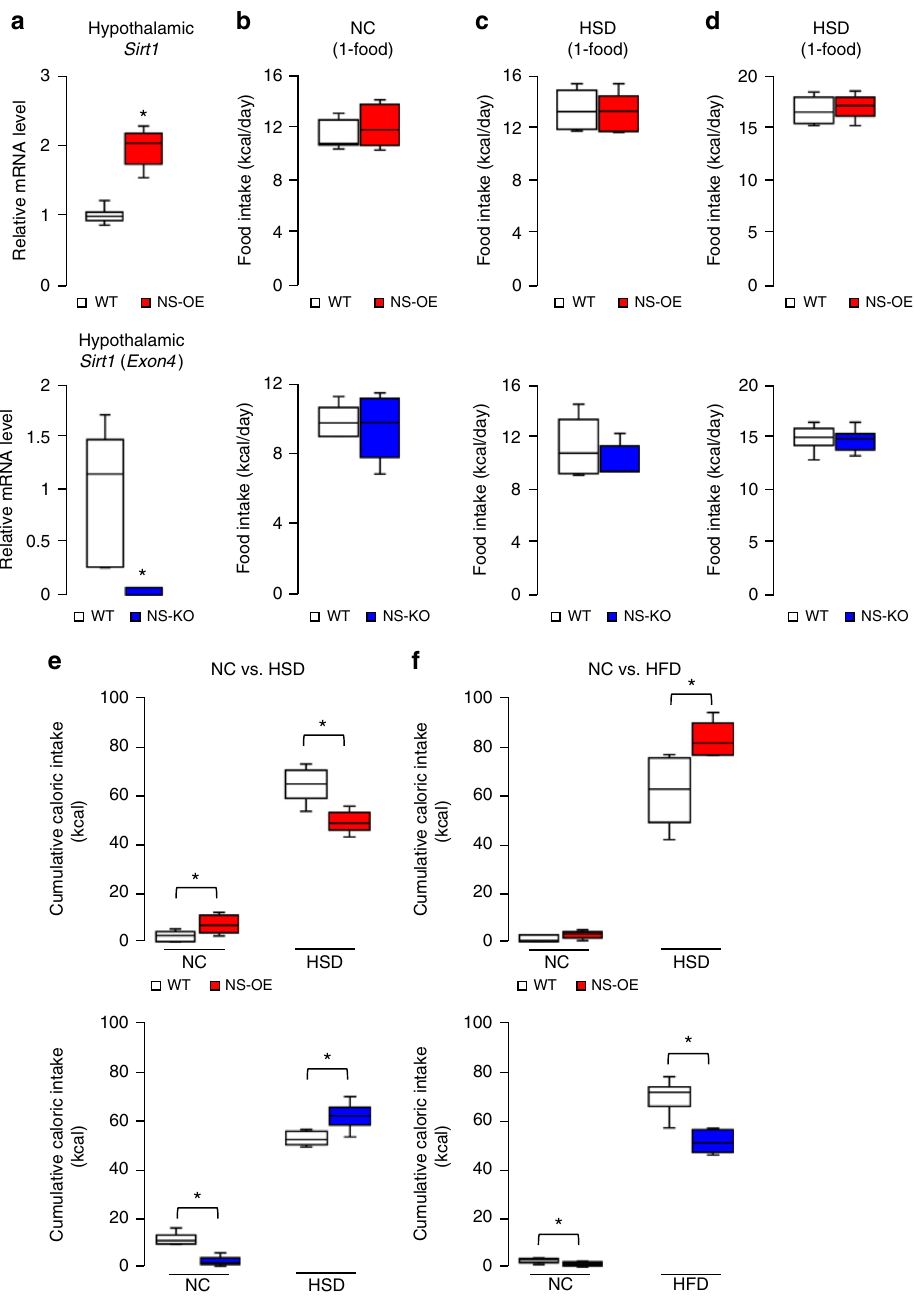
Fig. 1 Neuronal SIRT1 regulates macronutrient-based diet selection. a Hypothalamic Sirt1 mRNA expression of NS-OE (red) and NS-KO (blue) mice compared to wild-type mice (WT) ( n = 6 per group). b – d Food intake (kcal/d) for NS-OE and NS-KO mice fed NC only ( b ), HSD only ( c ) and HFD only ( d ) ( n = 6 per group). e , f Cumulative caloric intake for two-choice diets in 5-day diet selection experiments: NC vs. HSD ( e ) and NC vs. HFD ( f ) ( n = 6 per group). Data are shown as box and whisker plots (centre line, median; box limits, upper and lower quartiles; whiskers, the minimum and maximum value of a data set). * p < 0.05. See also Supplementary Fig. hypothalamic Oxt expression levels were increased and decreased SIRT1 knockout (OS-KO) mice. Brie fl y, Oxt-neuron-speci fi c Oxt- in OS-OE and OS-KO mice, respectively, compared to those in ires-Cre mice 28 were crossed with either Rosa26-Sirt1 mice or Sirt1- fl ox mice to generate OS-OE and OS-KO mice, respectively. wild-type littermates (Fig. 3a). Therefore, SIRT1 in Oxt neurons We performed immunohistochemistry to con fi rm that SIRT1 controlled Oxt expression. expression was manipulated speci fi cally in Oxt neurons, and that the acetylation levels of SIRT1 substrates were decreased speci- fi cally in Oxt neurons of OS-OE mice that received 3rd ICV different from those of wild-type mice (Fig. 3b – d; Supplementary injection of TSA (Supplementary Fig. 3). We found that Fig. 4a). Moreover, the locomotor activity, metabolic rates and